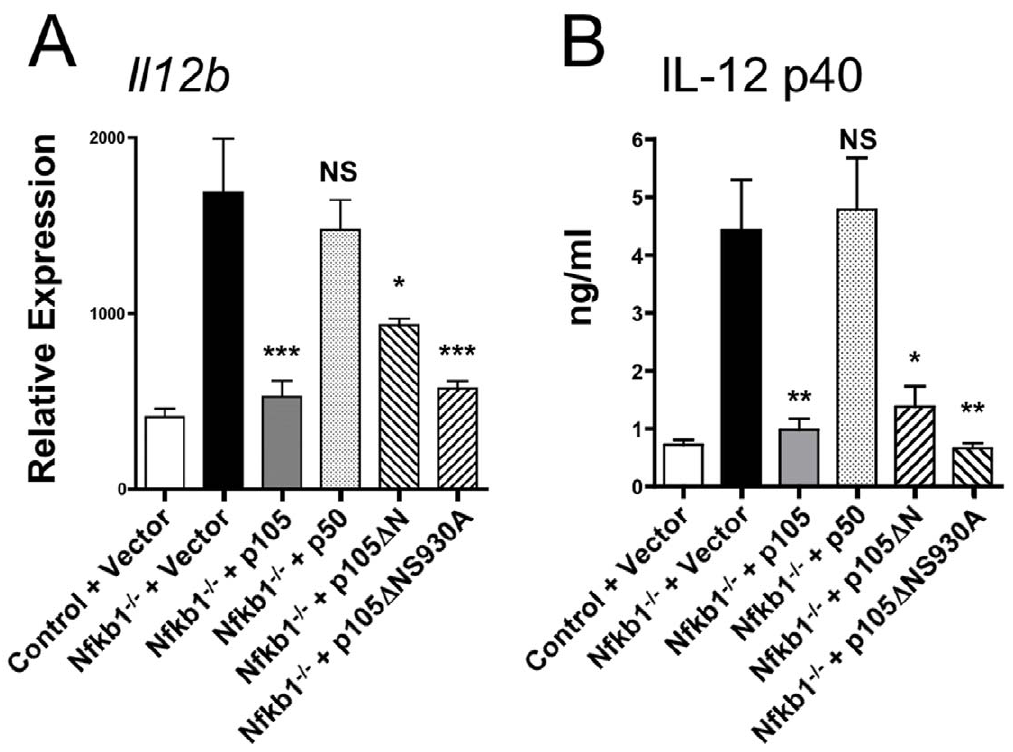
Figure 5. p105 D N but not p50 inhibit LPS-induced Il12b expression in Nfkb1 2 / 2 macrophages. A) Relative expression of IL-12 p40 ( Il12b ) as determined by RT-PCR in Il10 2 / 2 Rag2 2 / 2 (control) or Nfkb1 2 / 2 Il10 2 / 2 Rag2 2 / 2 ( Nfkb1 2 / 2 ) BMDM infected with empty vector (Vector) or viruses expressing the indicated proteins 4 hours after stimulation with LPS (N=6–9 individual mice per group). B) Levels of IL-12 p40 present in the supernatant of groups described in A, 2 hours after stimulation with LPS (N=3 individual mice per